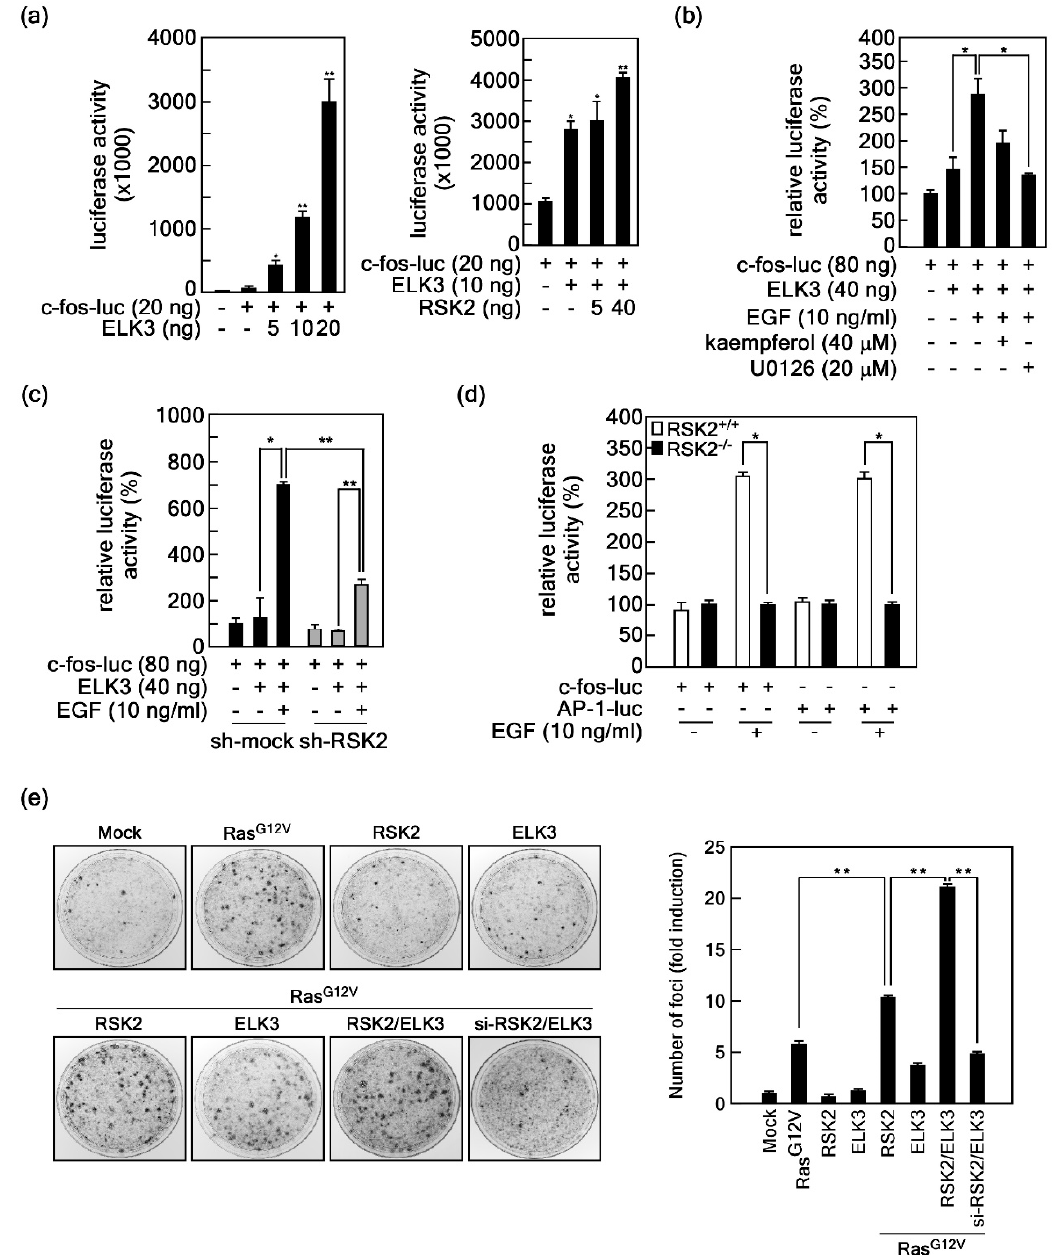
Figure 3. RSK2-mediated ELK3 transactivation activity regulates c-fos promoter activity-mediated AP-1 transactivation activity. ( a ) Left graph , ELK3 activates c-fos promoter activity. The c-fos -luciferase reporter plasmids were introduced into HEK293T cells with indicated doses of ELK3 and 80 pg of phRL -luciferase expression vector. Right graph , ELK3 transactivation activity is regulated by RSK2. The c-fos -luciferase reporter plasmids and ELK3 expression vectors were introduced into HEK293T cells with indicated doses of RSK2 expression vector and 80 pg of phRL-luciferase expression vector. ( b ) ELK3 transactivation activity was inhibited by inhibition of MEKs-ERKs-RSK2 signaling. The c- fos -luciferase reporter plasmid and ELK3 expression vector were introduced into HEK293T cells as indicated. Inhibitory effects of kaempferol, an RSK2 inhibitor, and U0126, a MEK inhibitor, on the transactivation activity of ELK3 induced by EGF were analyzed by examining luciferase activity. ( c – d ) Blockage of RSK2 suppresses ELK3-mediated c-fos promoter activity and AP-1 transactivation activity. ( c ) RSK2 knockdown suppressed EGF-induced ELK3 transactivation activity. The c-fos -promoter luciferase reporter plasmids and ELK3 expression vectors were introduced into sh-mock and sh-RSK2 stable cells and stimulated with EGF as indicated. ( d ) RSK2 knockout suppressed c-fos promoter activity and AP-1 transactivation activity. The c-fos- and AP-1-luciferase reporter plasmids were